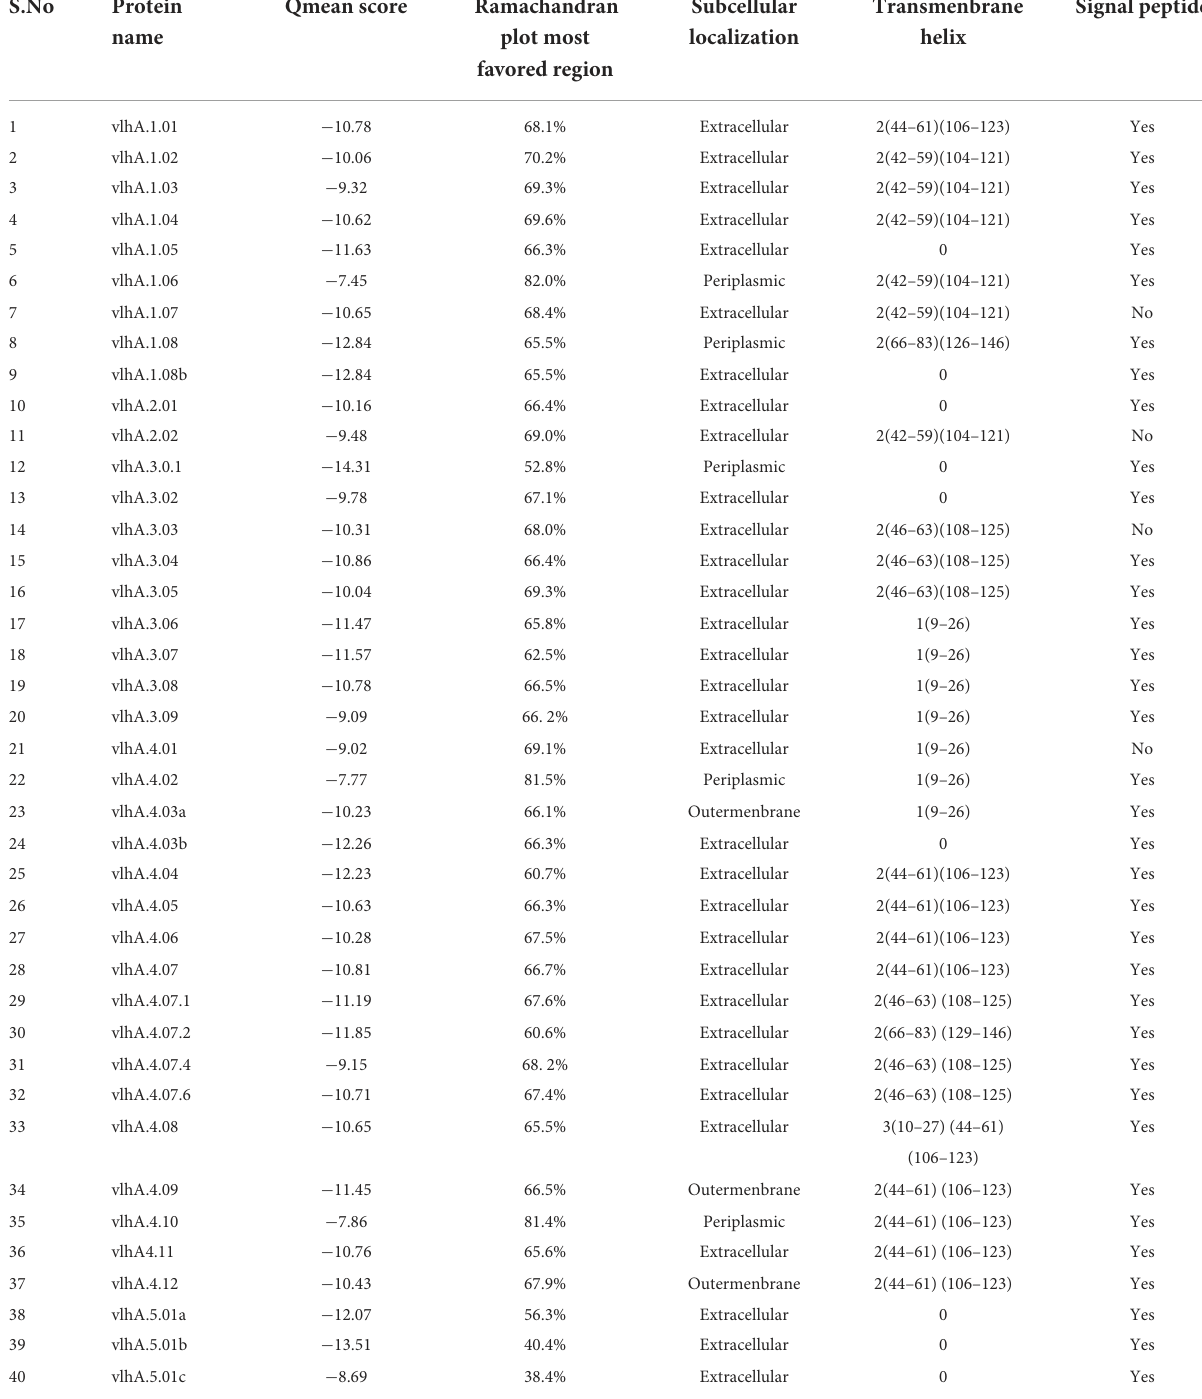
TABLE 4 Tertiary structural validation- Qmean Score, Ramachandran plot most favored region and functional analysis-Subcellular Localization, Transmembrane helix, Signal peptide of vlhA